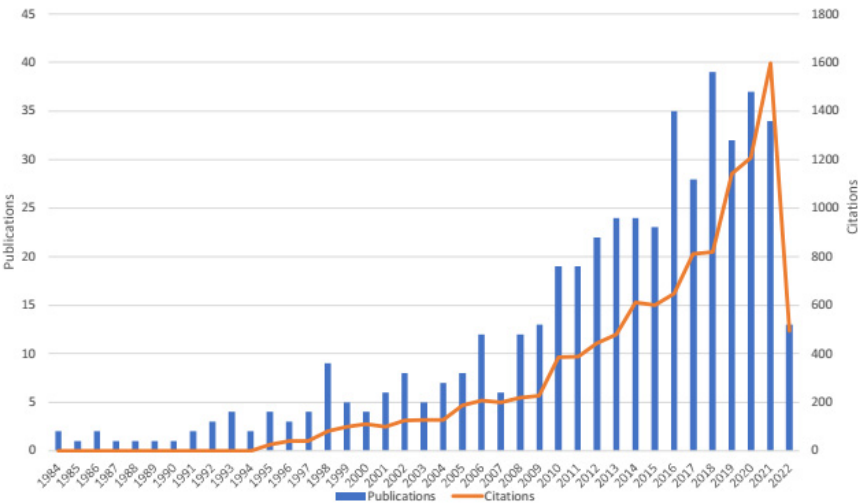
Figure 2. The number of publications and citations per year for 1984–2022.